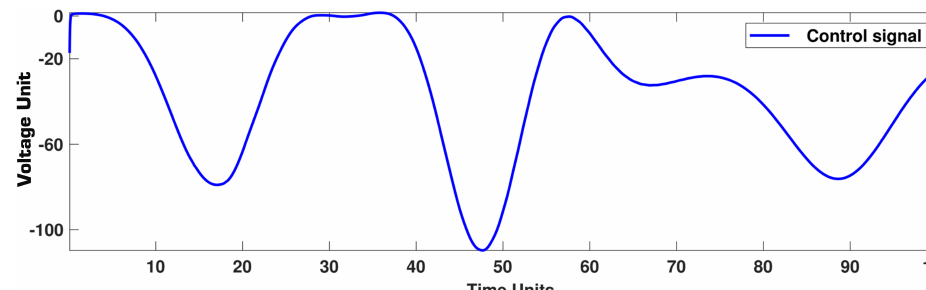
Figure 7. Example 2: Control signal.